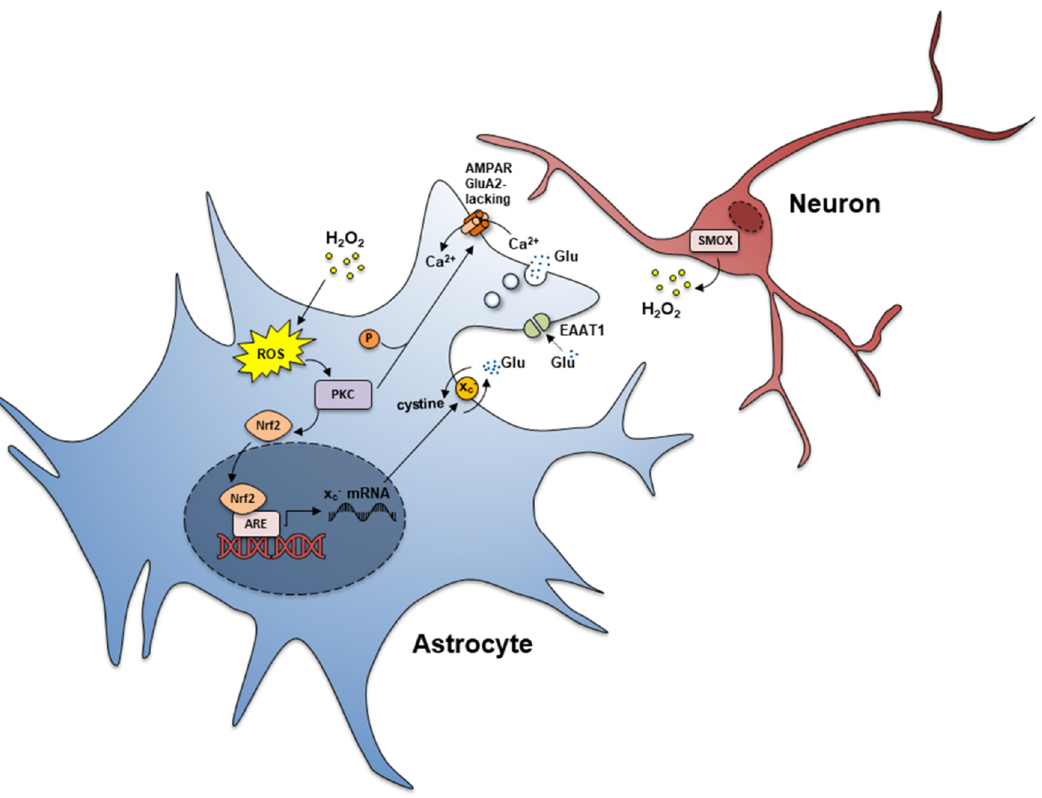
Figure 6. Possible mechanisms underlying dysfunctional pathways depending on chronic oxidative stress induced by SMOX overexpression. Neuronal SMOX overexpression is responsible for H 2 O 2 increase leading to ROS augmentation within astrocytes. ROS increase induces PKC-Nrf2 cascade. The increase in PKC lead to higher phosphorylation of Glur1Ser831 of AMPAR, the phosphorylation and nuclear translocation of Nrf2. The transcription factor Nrf2 is the major regulator of phase II ARE genes. The nuclear translocation of Nrf2 induces a higher Xc- transporter expression, with a deregulated cystine import and glutamate export. ROS contribute to the reduction of EAATs and consequently a reduced glutamate uptake from the synaptic cleft. In the astrocytes of Dach-SMOX mice, the increase in Glur1Ser831 phosphorylated in the AMPA receptors contributes to the expression of functional GluA2-lacking AMPA receptors evoking Ca 2+ influx and vesicular glutamate release.